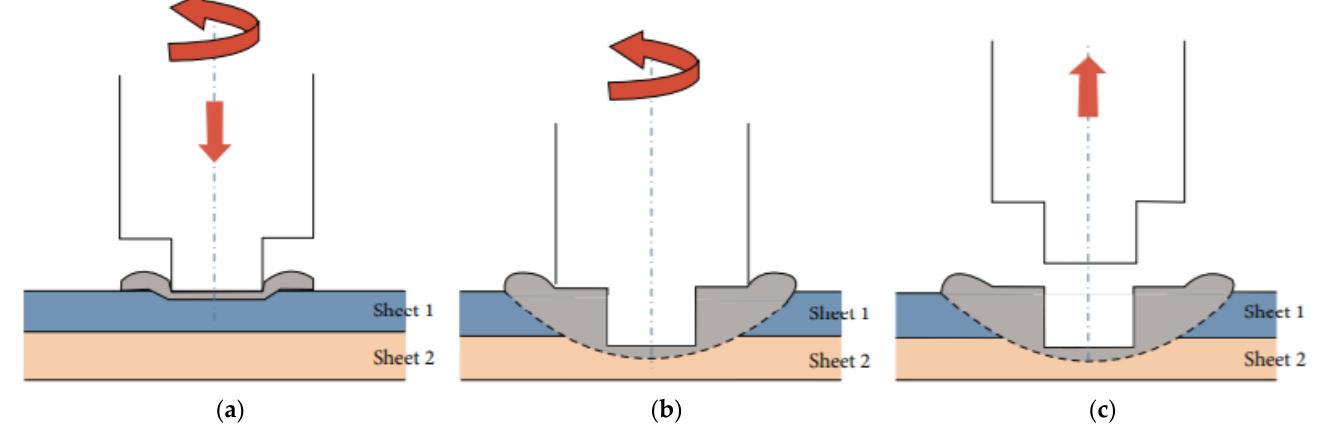
Figure 1. FSSW process: ( a ) plunging, ( b ) stirring, and ( c ) retracting [5]. Increasing the feed rate leads to a reduction in friction heating, grain, ductility, and the strain hardening exponent of the joint. Increasing the feed rate also causes increases in fragmentation and homogenization [6].